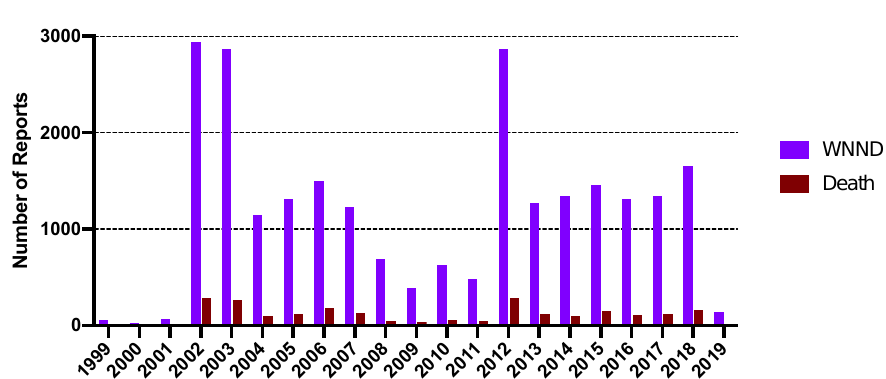
Figure 1. Annual morbidity and mortality associated with WNV in the United States. WNV neurological disease cases (purple bars) and deaths (red bars) that were reported to the United States Centers for Disease Control and Prevention are displayed. As of August 26, 2019, 143 cases of WNND and 11 fatalities have been reported for the year.